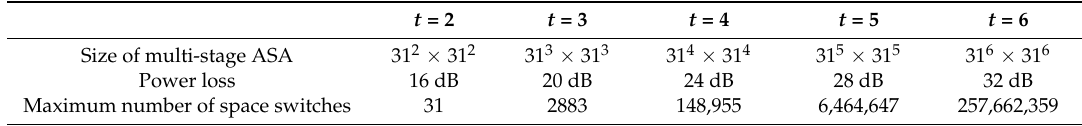
Table 1. The power loss and maximum number of space switches used in a general multi-stage 31 t × 31 t ASA switch for different values of integer t . t = 2 t =